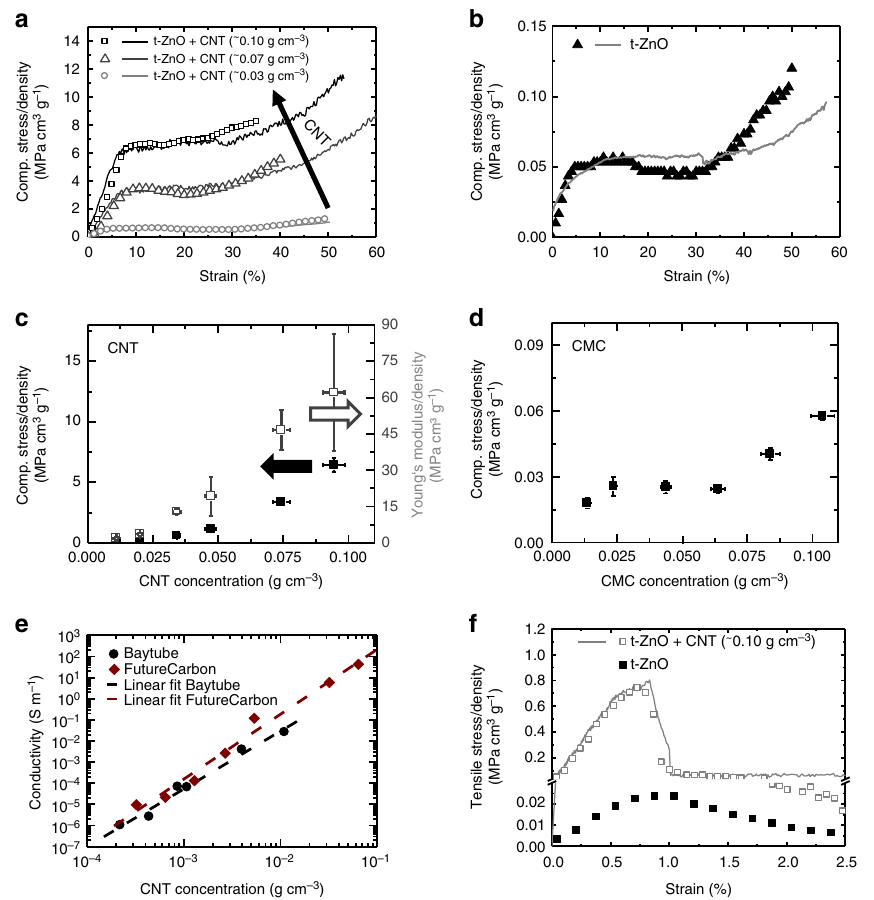
Fig. 2 Mechanical and electrical properties of the CNTT/t-ZnO composite structure. a Compressive stress – strain curves for CNTT/t-ZnO networks containing different amounts of CNT normalized to the density of each structure (solid curves represents the corresponding results from FEM); b Compressive stress – strain curves for the pure t-ZnO network normalized to density (solid curve represents the corresponding FEM result); c Compressive strength and Young ’ s modulus (normalized with respect to density) vs. CNT concentration (error bars are s.d.); d Compressive strength (normalized with respect to density) vs. cellulose (CMC) concentration (stabilizing agent in the CNT dispersion) (error bars are s.d.); e Conductivity as a function of carbon nanotube concentration for two different CNT dispersions (CarboDis TN (Future Carbon), and Baytubes DW 55 CM (Bayer MaterialScience)); f Stress – strain curves under tensile loading for the pure ceramic network and for a network containing 0.1 g cm − 3 carbon nanotubes (values are corrected by the density of the structures; solid curves represent the corresponding results from FEM). Please note that the template density was set to 0.3 g cm − 3 for all mechanical and electrical measurements